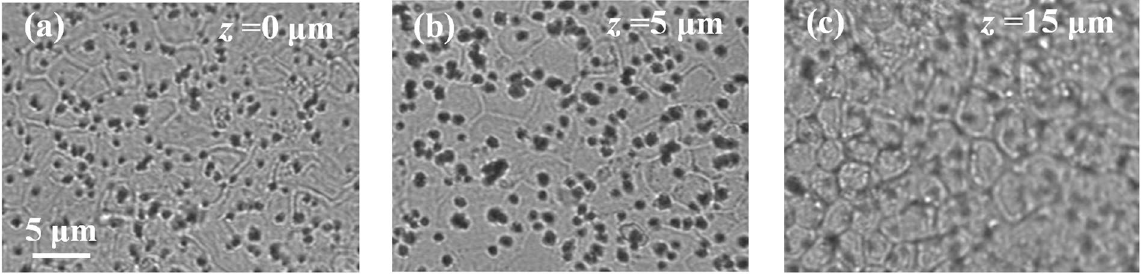
Figure 2. Examples of bright-field images of aldosterone treated cells: ( a ) focus on the permeable membrane (z = 0); ( b ) above the membrane at z = 5 and ( c ) at z = 15 μ m.